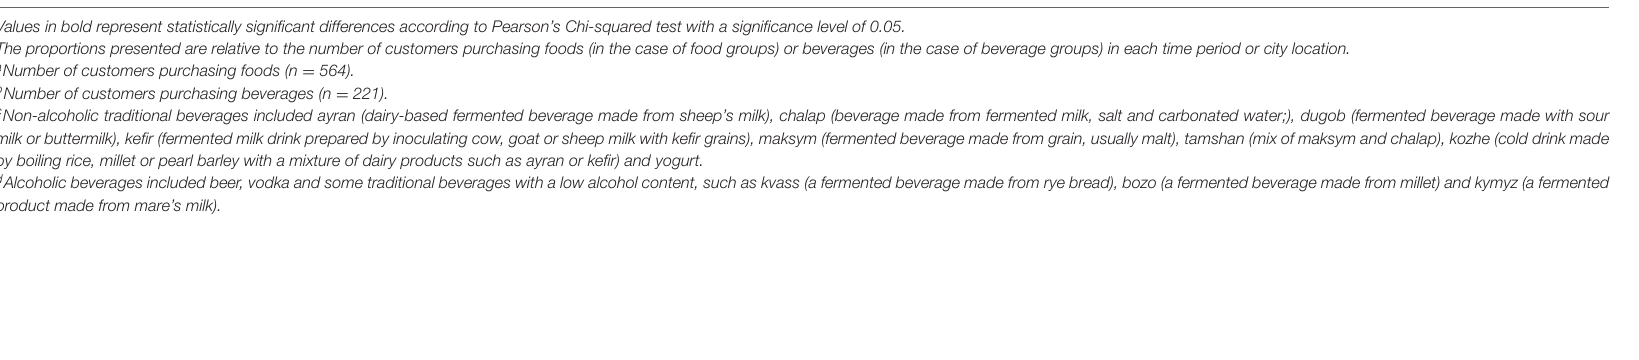
TABLE 1 | Distribution of the street food purchases throughout the day and by city location, by food and beverage groups. N a Savory pastries Bread Sandwiches Fruit Tea and Main dishes Sweet pastries and snacks and confectionery